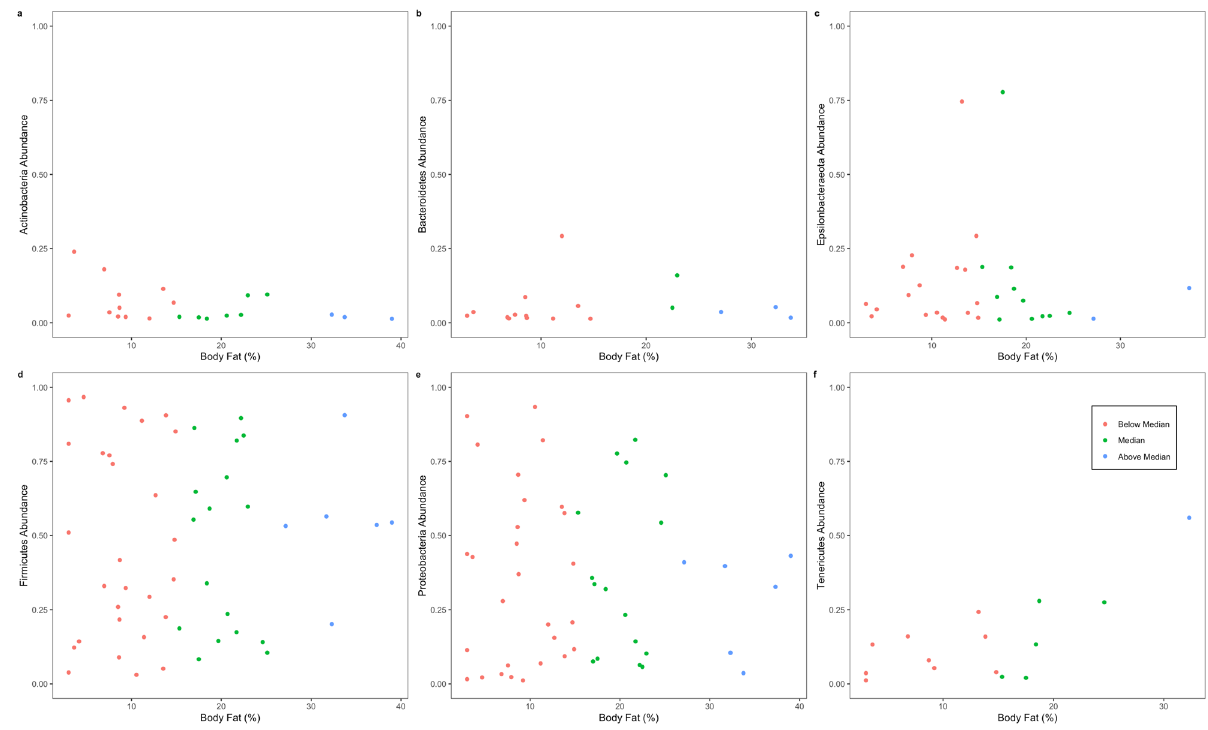
Figure 2. The relative abundance of major phyla (≥ 1%) in brown bear ( Ursus arctos ) gut microbiomes across individuals with different percent body